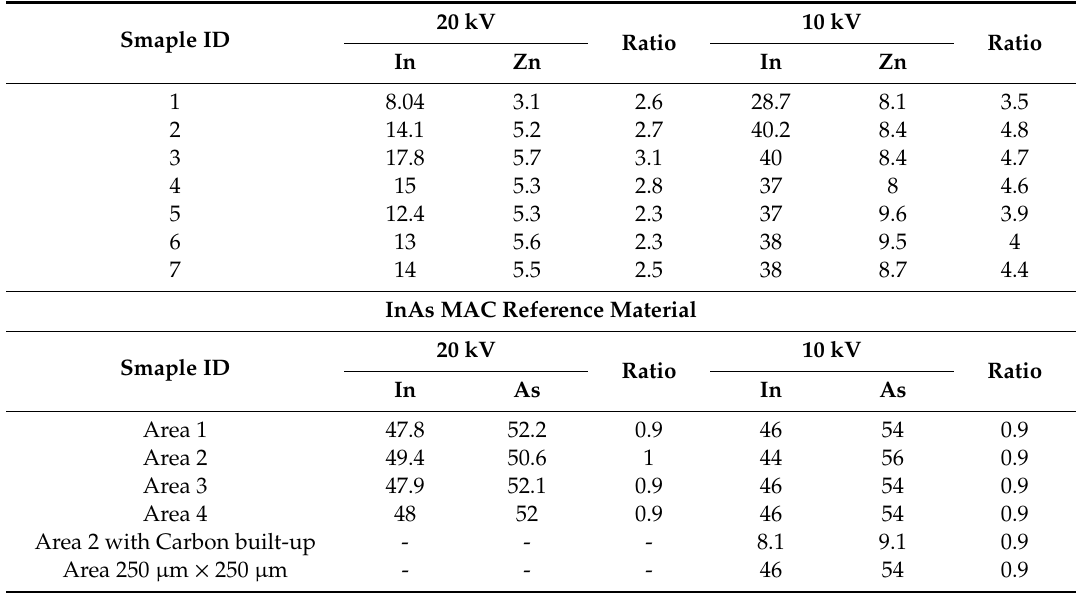
Table 1. Energy-dispersive X-ray spectroscopy (EDS) investigation of the films (S1 to S7) at 10 and 20 kV; the results are presented in atomic % for the calculation of the ratio between the cations. Highlighted in grey are the columns indicating the ratio between the In / Zn cations in the films and In / As cation in the reference material used for the evaluation of the analytical best practice. 20 Smaple ID